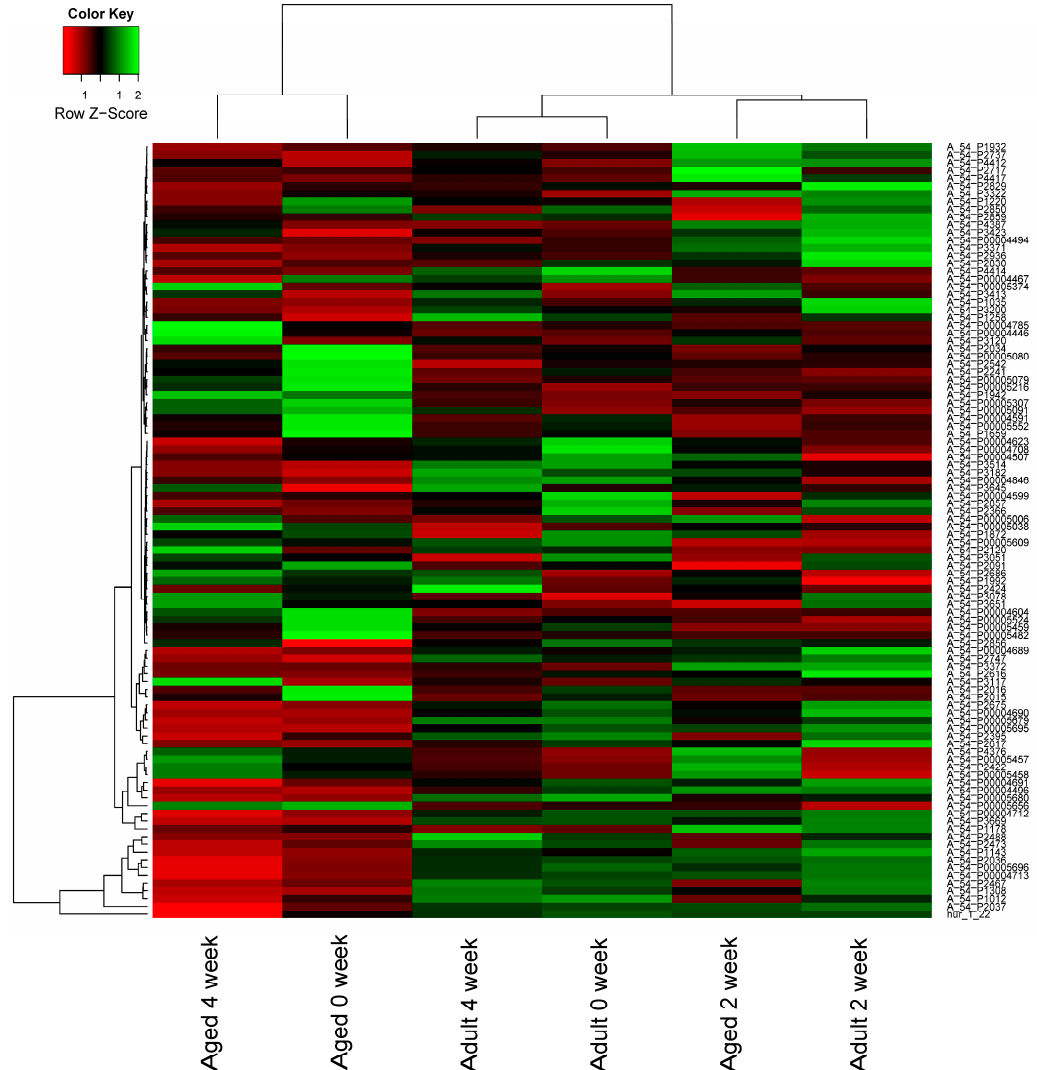
Figure 2. Heat map of differentially expressed microRNAs (miRNAs) in fracture healing. Red represents up-regulation and green represents down-regulation.